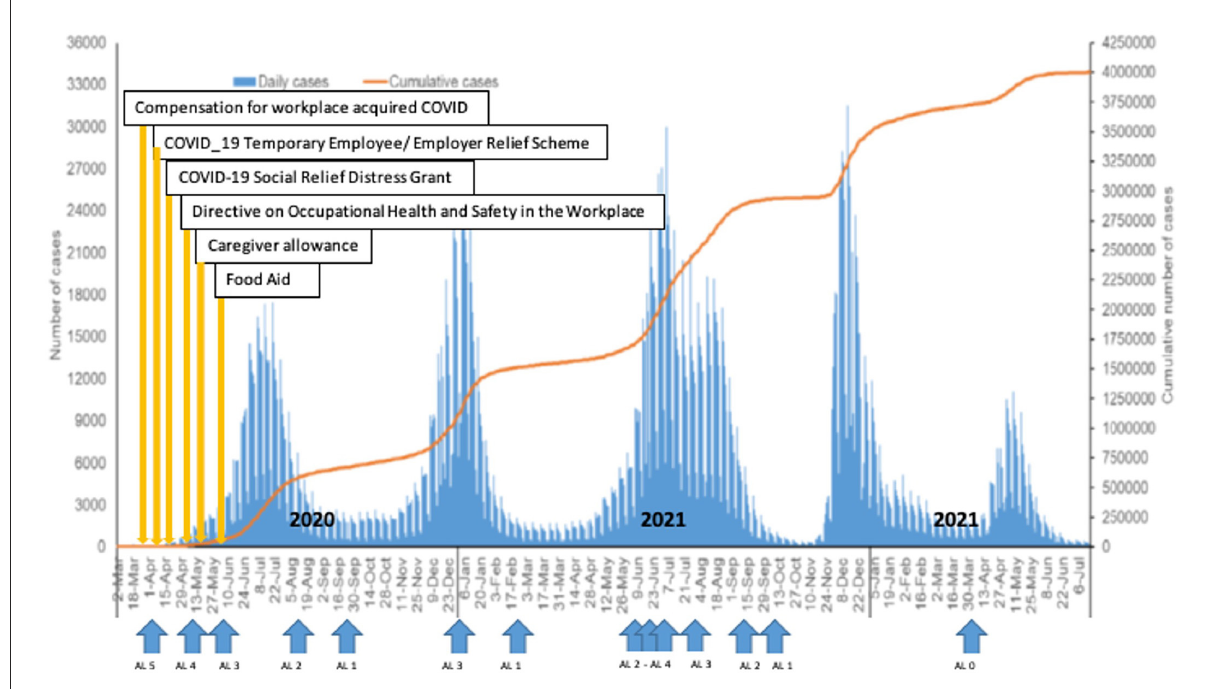
FIGURE1 South African COVID-19 Alert levels (35) and dates of specific interventions. AL = Alert Level.